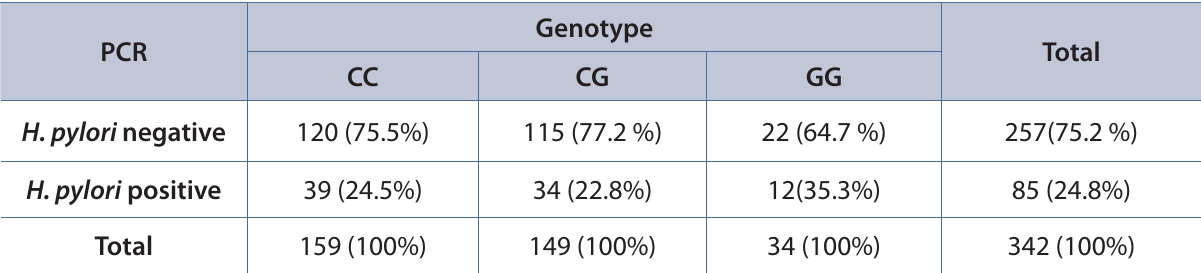
Table 2. Genotype distribution of Tp53 polymorphisms and H. pylori detection in